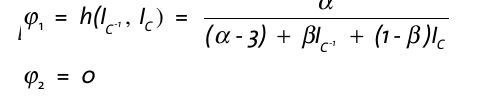
Figure 1 (left): Model predictions of the storage modulus G’ and loss modulus G’’ for the IUPAC-LDPE melt (sample A) using the K-BKZ model with the material parameters given in Table 1. Table 1: Material parameter values using the K-BKZ model for fitting data of the IUPAC-LDPE (sample A) at 150 ° C ( α = 14.38, θ =